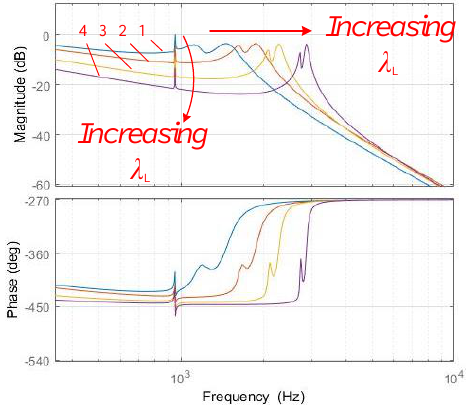
 . Figure 16. Bode diagram of multi-parallel HCGIs with difference λ L L